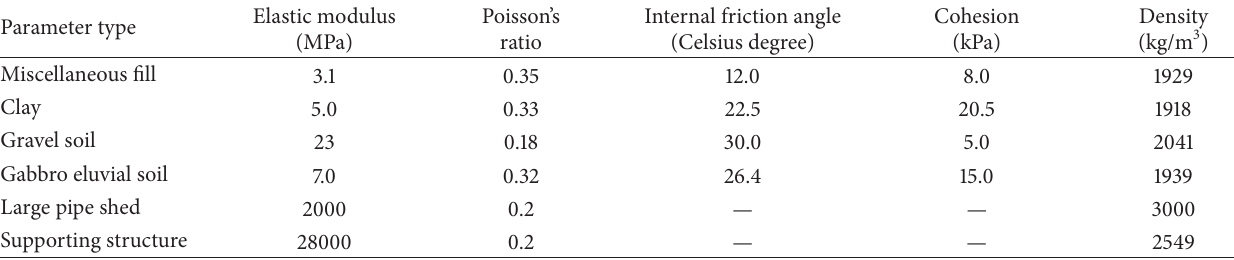
Table 1: Parameters of surroundings and supporting system.